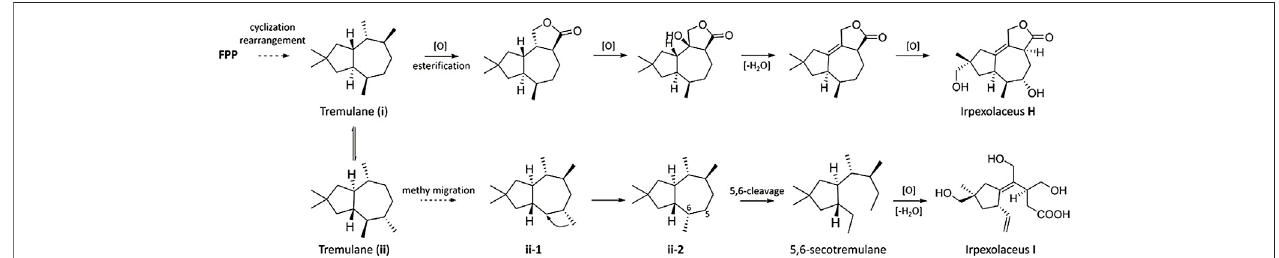
FIGURE 5 | Proposed biosynthetic pathway for 1 and 2 .